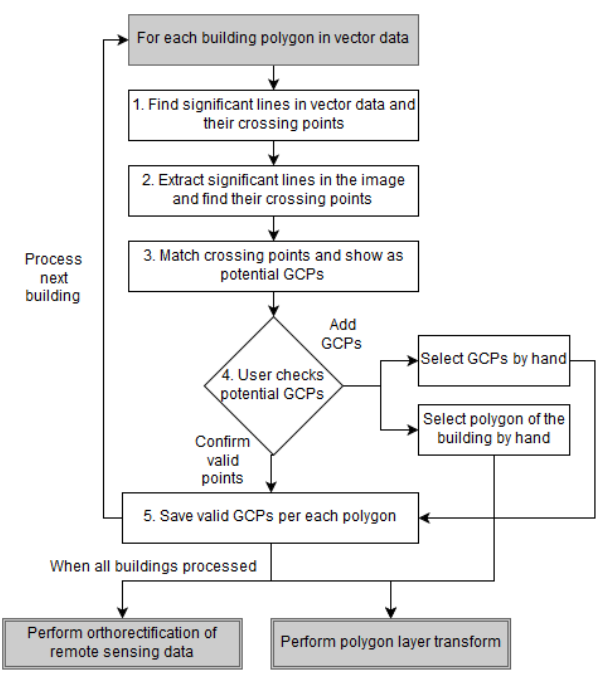
Fig. 2. Basic steps of semi-automatic GCP selection methodology.